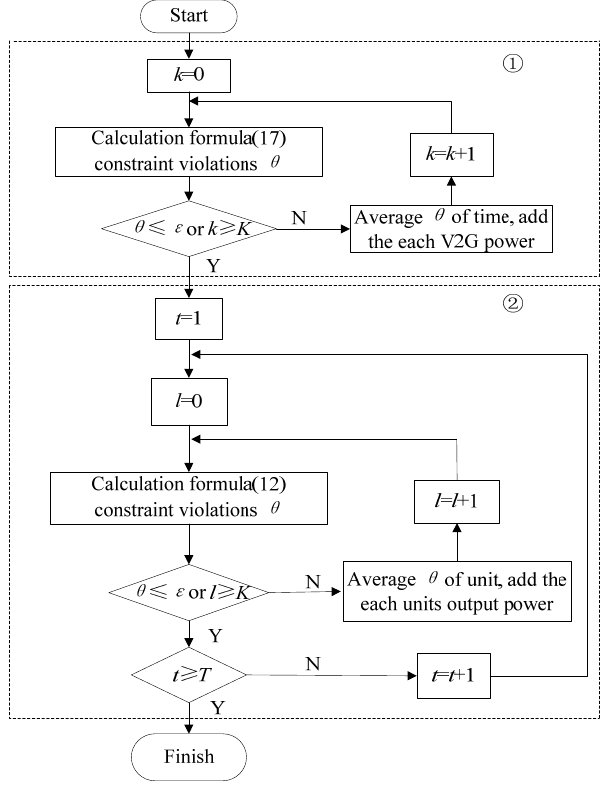
Figure 3. Flow chart for two-step processing.